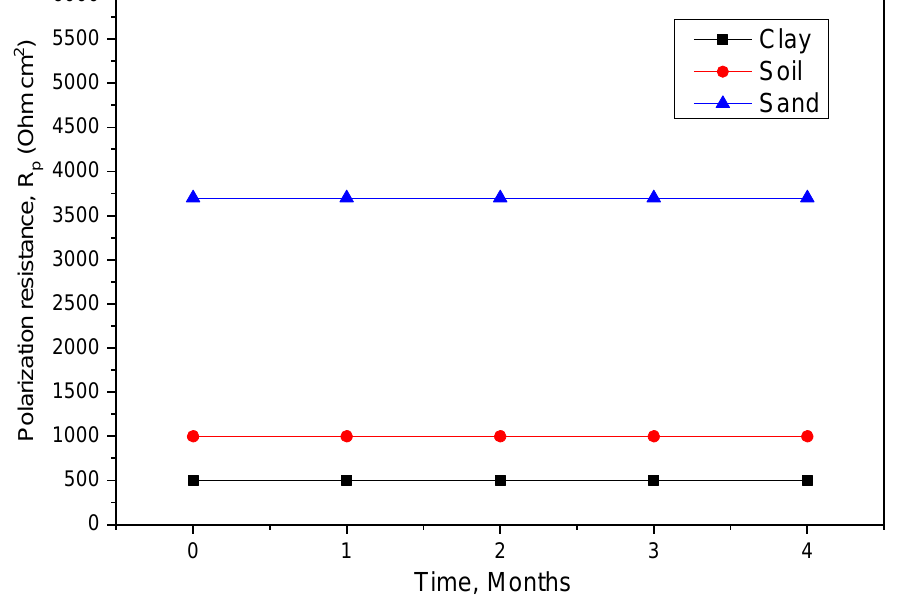
Figure 6. Polarization resistance as a function of immersion time of coated steel. Table 5. Polarization resistance corrosion current and corrosion potential ( for clay).